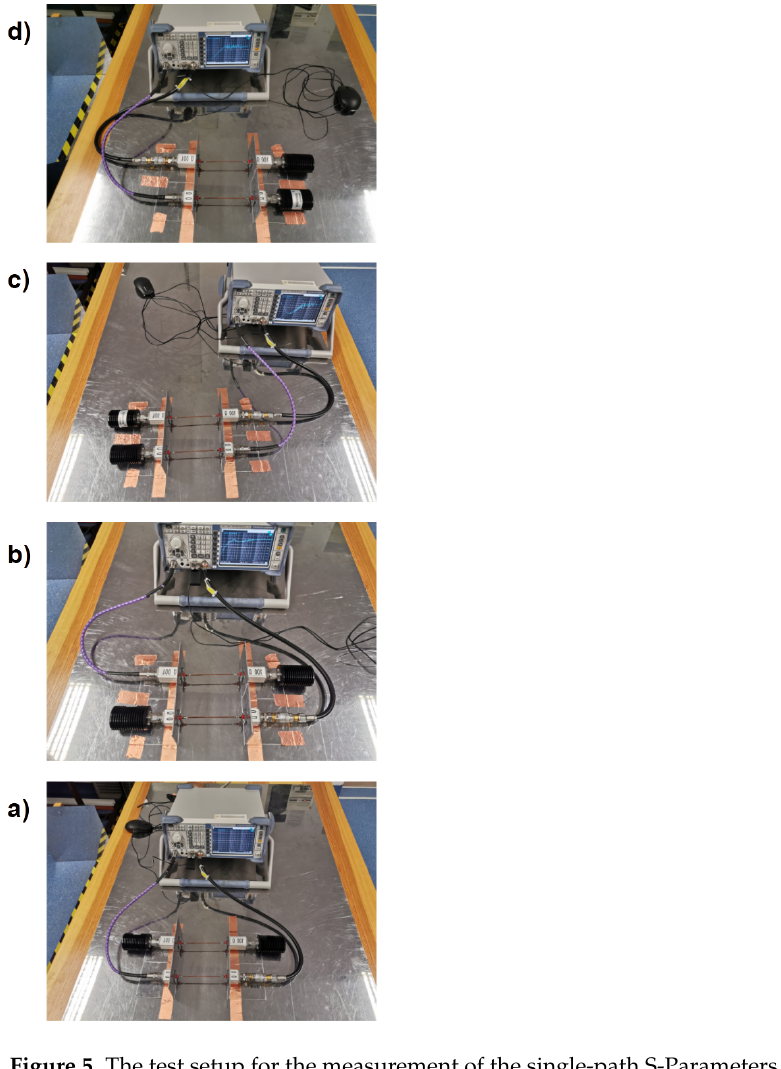
Figure 5. The test setup for the measurement of the single-path S-Parameters of the four-port from Figure 1 for the single paths: 1-2 ( a ), 2-3, ( b ), 2-4 ( c ), and 1-3 ( d